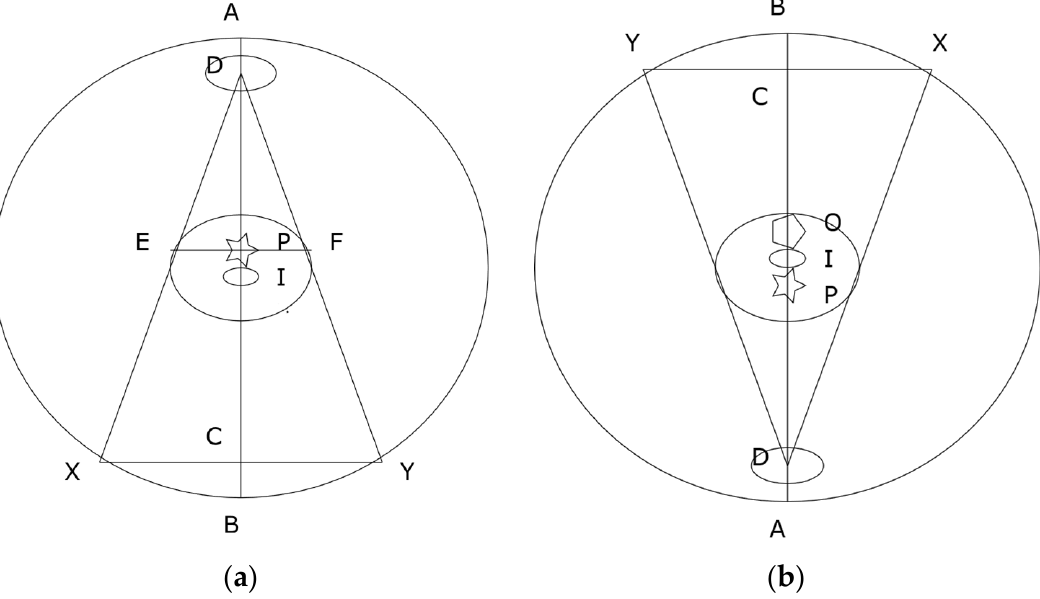
Figure 8. Schematic anterior-posterior (AP) ( a ) and posterior-anterior (PA) ( b ) projections: D is the center of X-ray tube; I is the system’s iso-center; P is the projection center; O is the projection center defined by AP projection; DC is the source to detector distance (SDD) and DI is the source to iso-center distance (SID).